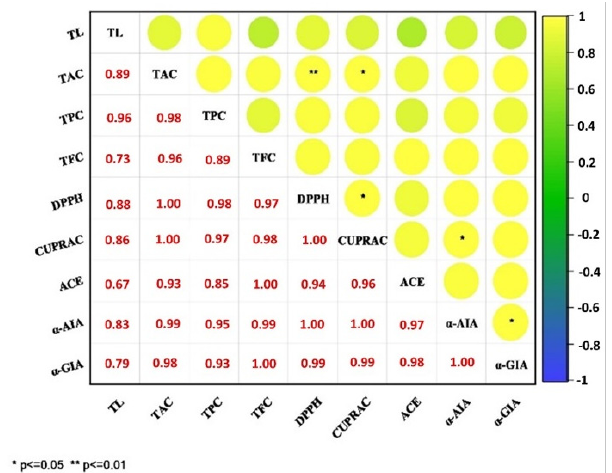
Figure 2. Pearson’s correlation coefficients of TL, TAC, TPC, TFC, DPPH, and ACE inhibitor and